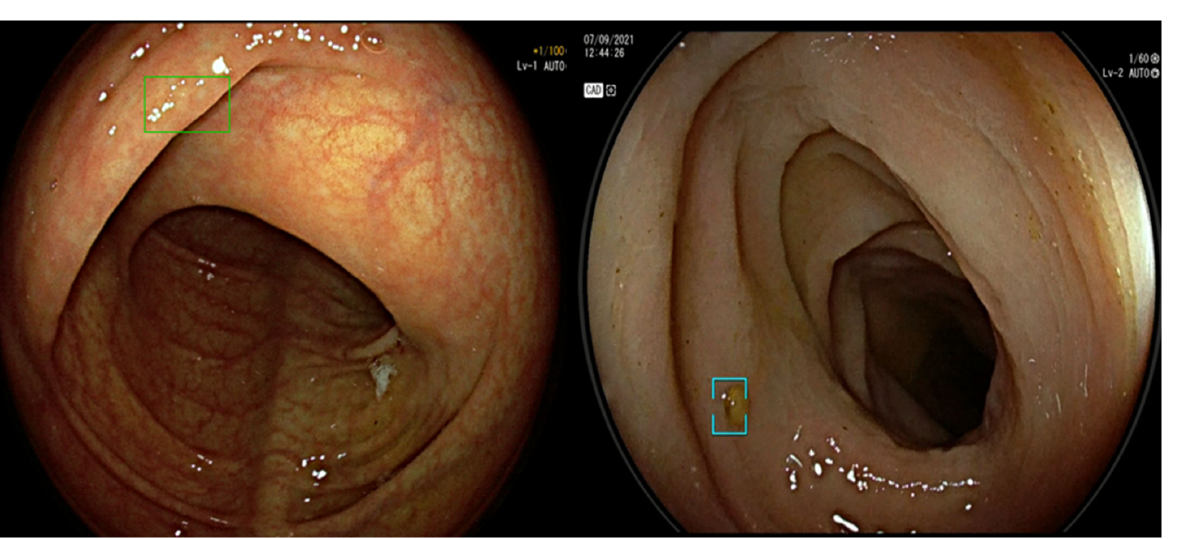
Figure 4. Example of false positive activation of two different Computer-Aided Detection systems due to colonic fold and stool residue.